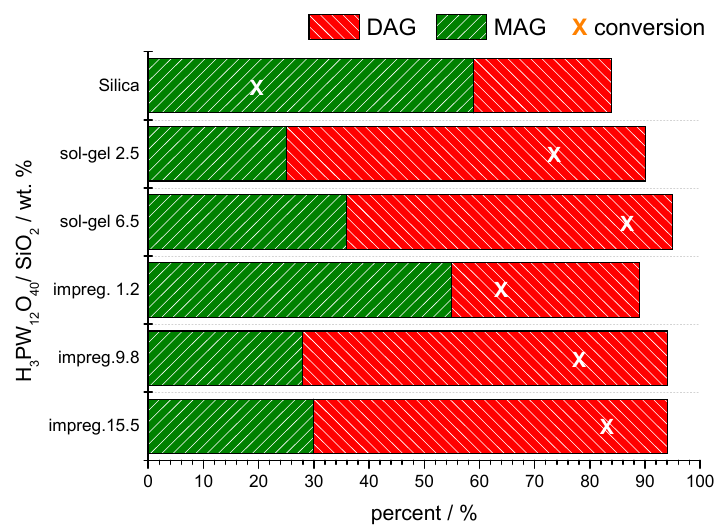
Figure 8. Impact of catalyst loading on the conversion and selectivity of the main reaction products of the esterification of glycerol with acetic acid over H 3 PW 12 O 40 /SiO 2 (adapted from ref. [50]). Reaction conditions: molar ratio of glycerol to acetic acid (1:16); temperature (393 K); catalyst weight (2.0 g).